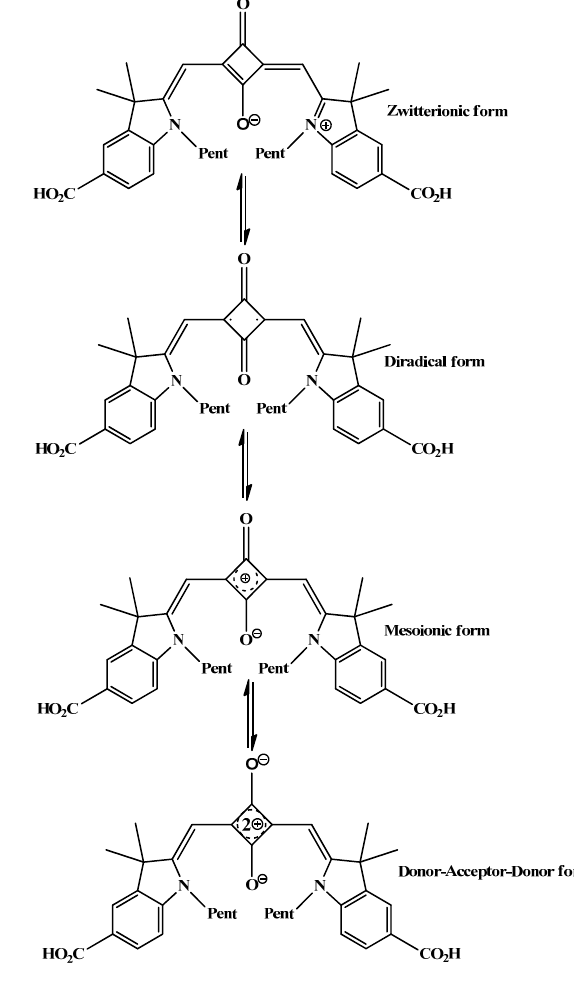
6 of 12 0.92 747 −